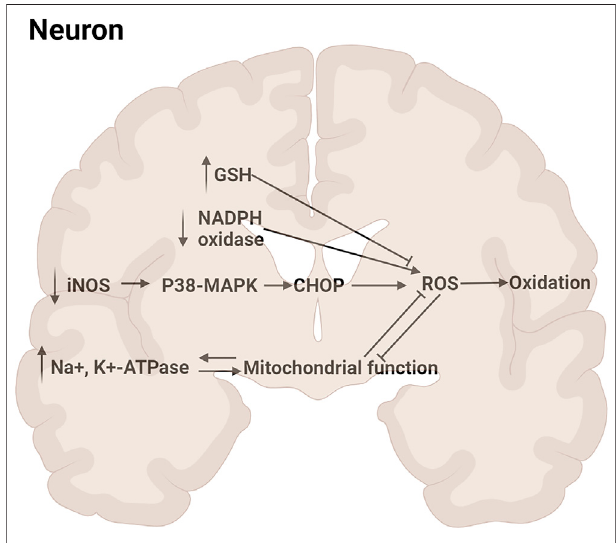
FIGURE 6 | Mechanisms involved in the anti-oxidation by